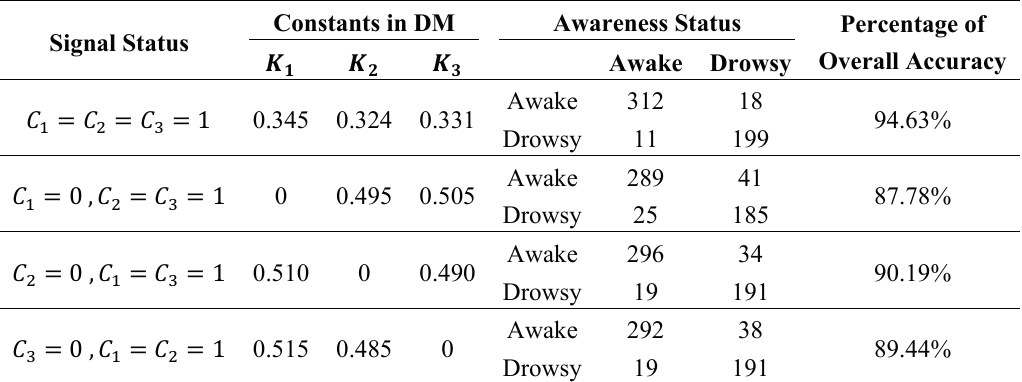
Table 4. Performance of the designed system in case of input signal loss. Signal